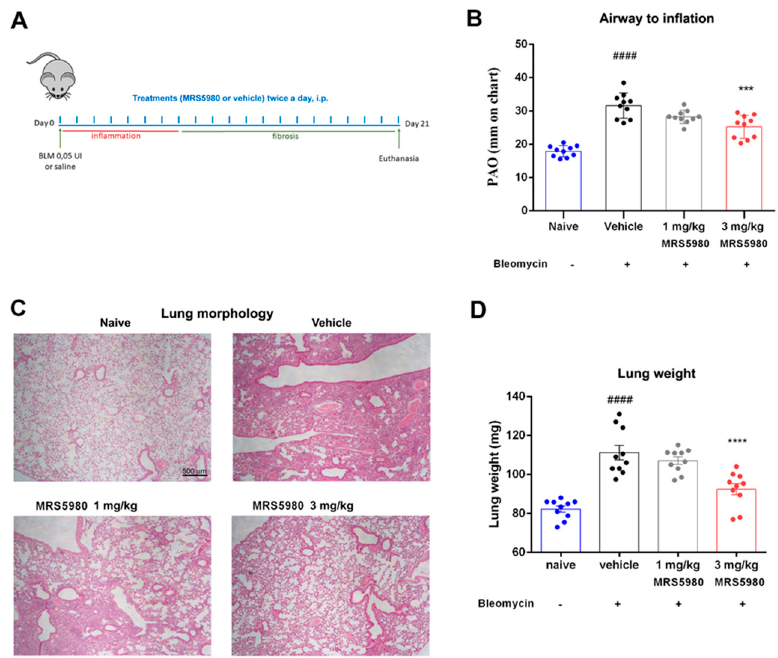
Figure 1. ( A ) Graphical scheme indicating the experimental protocol and treatments administered (BLM = bleomycin). ( B ) Lung resistance to airflow measured through the calculation of pressure at airway opening (PAO). ( C ) Histopathological assessment of lung parenchyma by hematoxylin and eosin staining of the different experimental groups (magnification 4 × ). ( D ) Bar graph showing the quantification of lung weight as a marker of lung injury in each experimental group. Data are mean ± S.E.M for n = 10 mice per group; #### p < 0.0001 vs. naïve; *** p < 0.001 and **** p < 0.0001 vs. vehicle.